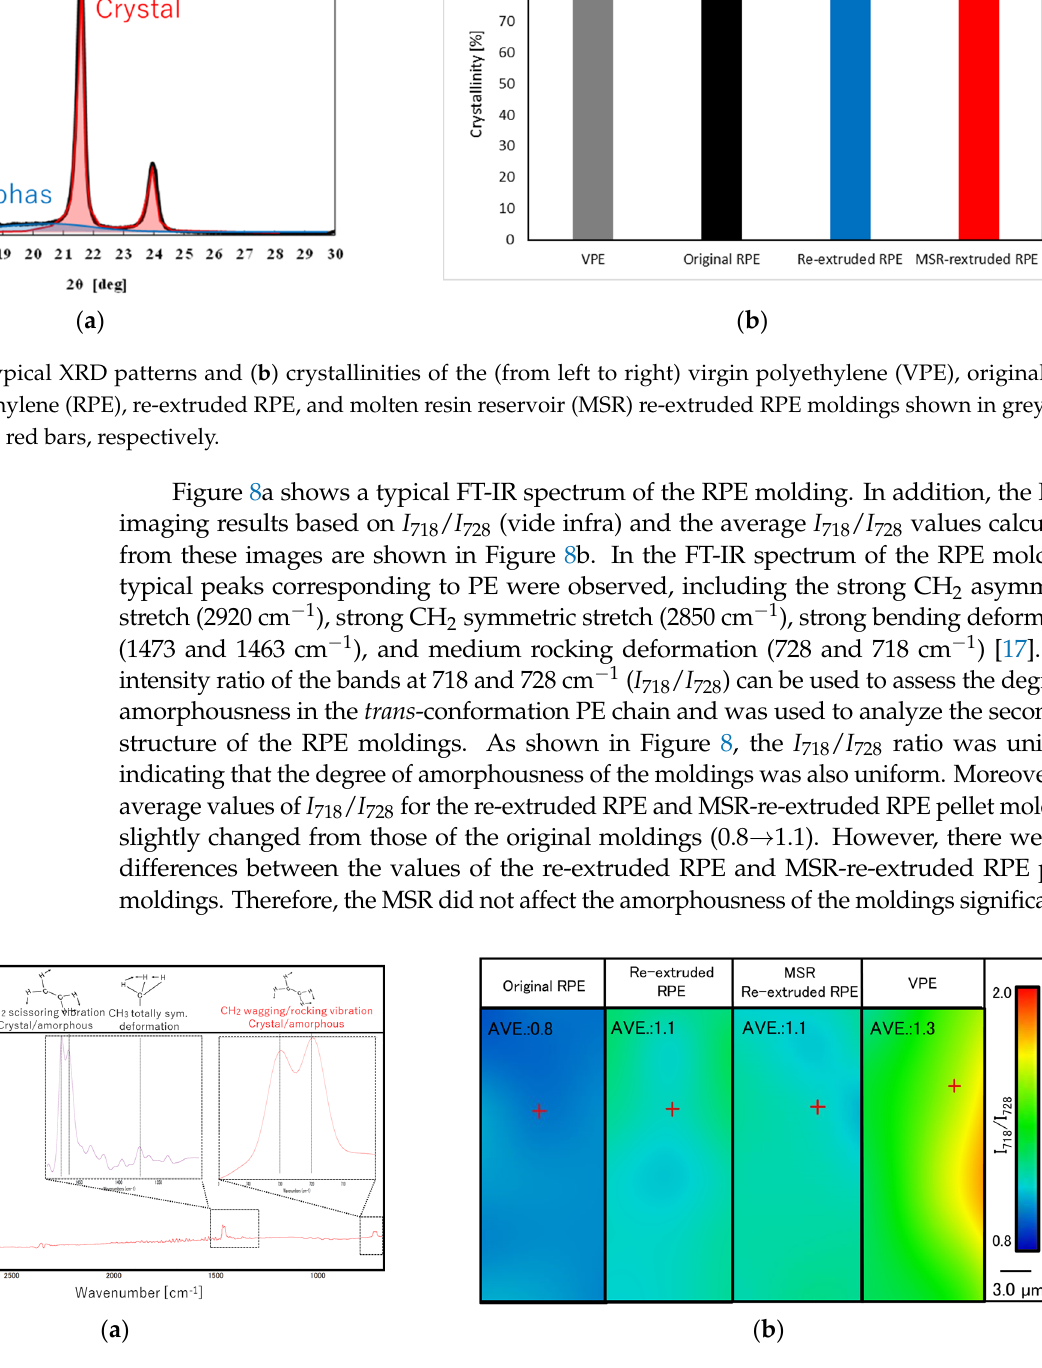
Figure 8. ( a ) Representative Fourier transform infrared (FT-IR) spectrum of the recycled polyethylene (RPE) moldings and ( b ) average values of the I 718 / I 728 ratio calculated from the FT-IR imaging results for (from left to right) the original RPE, re-extruded RPE, molten resin reservoir (MSR) re-extruded RPE, and the virgin PE (VPE) samples, respectively.